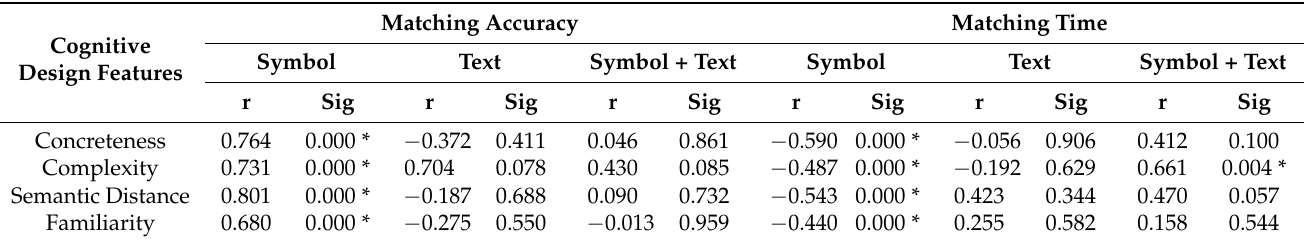
Table 10. Pearson Correlation for Cognitive Design Features and Display